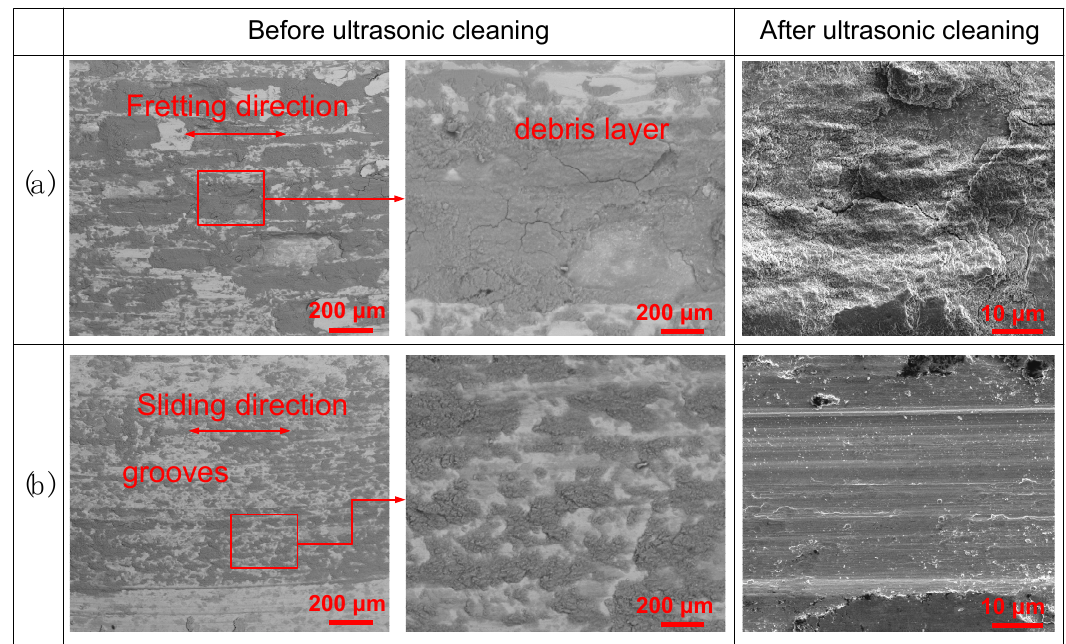
Figure 6. SEM morphologies of the worn surfaces: ( a ) fretting; ( b ) sliding. SEM morphologies of the loose debris are displayed in Figure 7. During fretting tests, flaky wear debris peeled off and was repeatedly crushed and ground, mainly forming fine particles (Figure 7a). Under the sliding condition, the substrate material was mainly peeled off by abrasion, but part of the debris moved out of the contact area due to the large relative displacement amplitude. So, the sliding wear debris contained not only fine particles but also large flakes and chips. According to our previous study [26], the flaky and striped sliding wear debris looks brown to the naked eye, that is to say, the same as the base material of CuNiA. Yet, due to reflection, it is not easy to be identified under the microscope, as we can see in Figure 3.